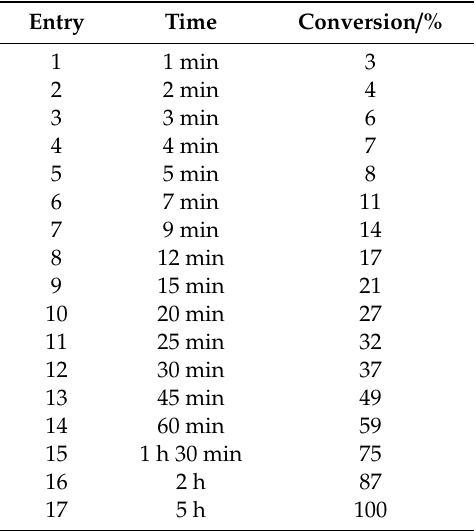
Table A2. Reduction of acetophenone ( 1 ) to 1-phenylethanol ( R )- 2 . Change from standard procedure: bu ff er (to 2 mL), MTBE (1668 µ